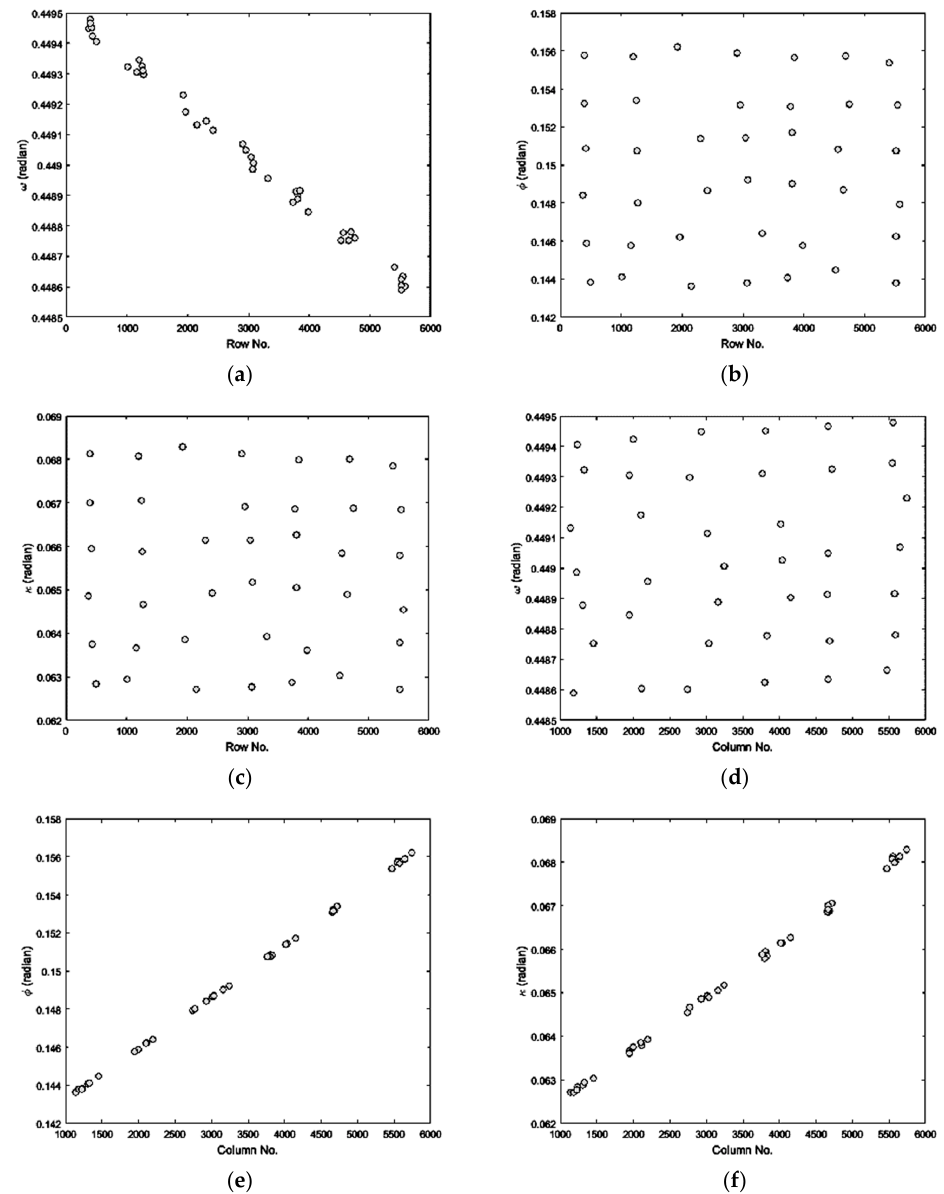
Figure 4. Scatter plot of the direction of IBs with respect to the rows- and columns-number of CIPs: ( a ) ω vs. the rows-number; ( b ) φ vs. the rows-number; ( c ) κ vs. the rows-number; ( d ) ω vs. the columns-number; ( e ) φ vs. the columns-number; ( f ) κ vs. the columns-number.